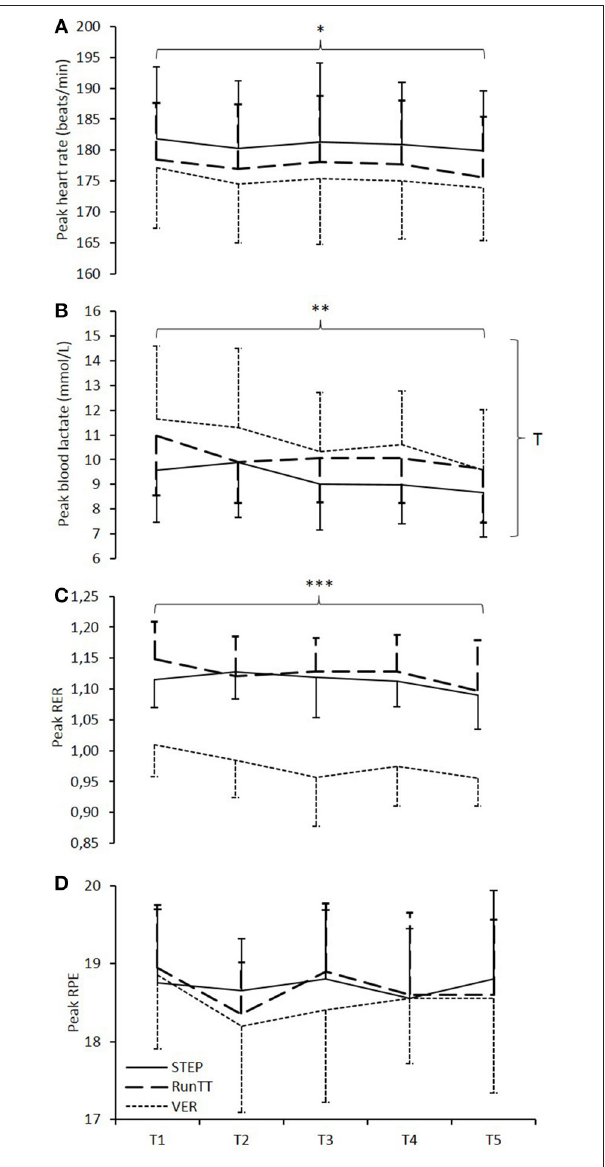
FIGURE 2 | Peak responses during the five (T1–T5) incremental tests to volitional exhaustion (STEP, solid line), verification trials (VER, dotted line) and four-minute running time-trials (RunTT, dashed line) for (A) heart rate, (B) blood lactate concentration, (C) RER, and (D) RPE. *STEP significantly higher than VER and RunTT, P ≤ 0.05. **STEP significantly lower than VER, P = 0.001. ***VER significantly lower than STEP and RunTT, P ≤ 0.001. T significant trial effect, P =